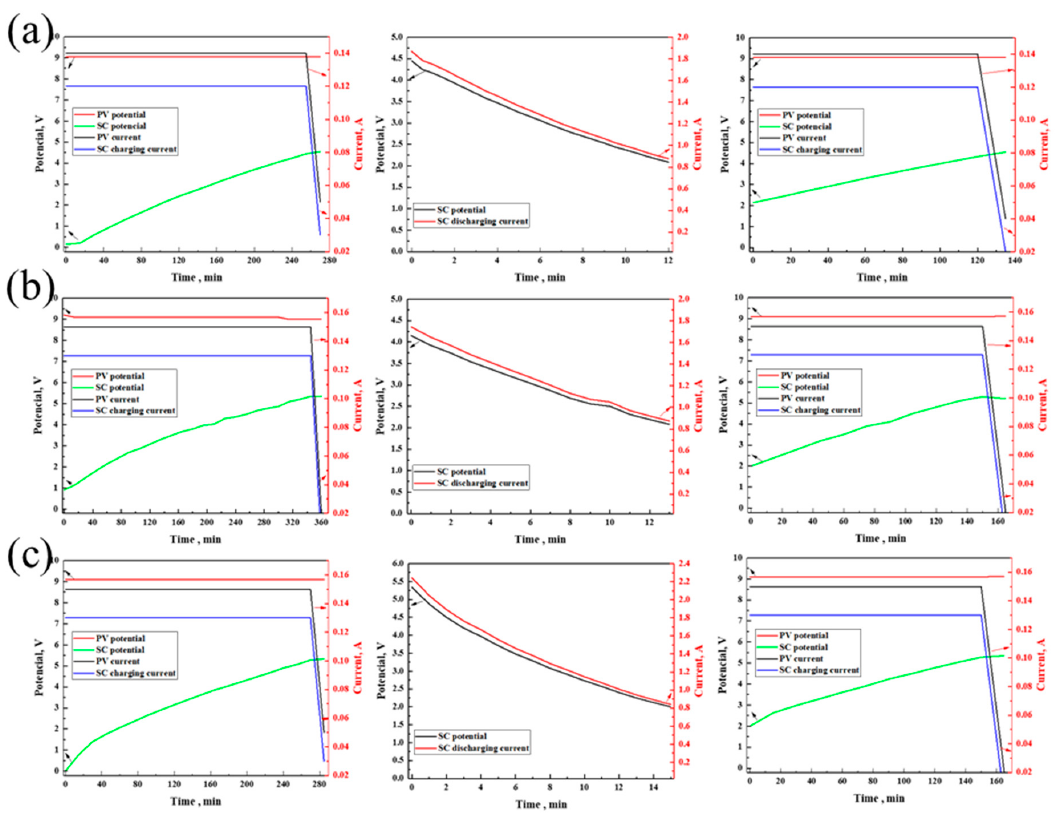
Figure 5. Characteristics of three demonstrators under charging supercapacitors to V Cw , under discharge of supercapacitors to V = 2 V, and under second charging supercapacitors to V Cw from top to bottom for ( a ) demonstrator no. 1, ( b ) demonstrator no. 2, and ( c ) demonstrator no. 3.